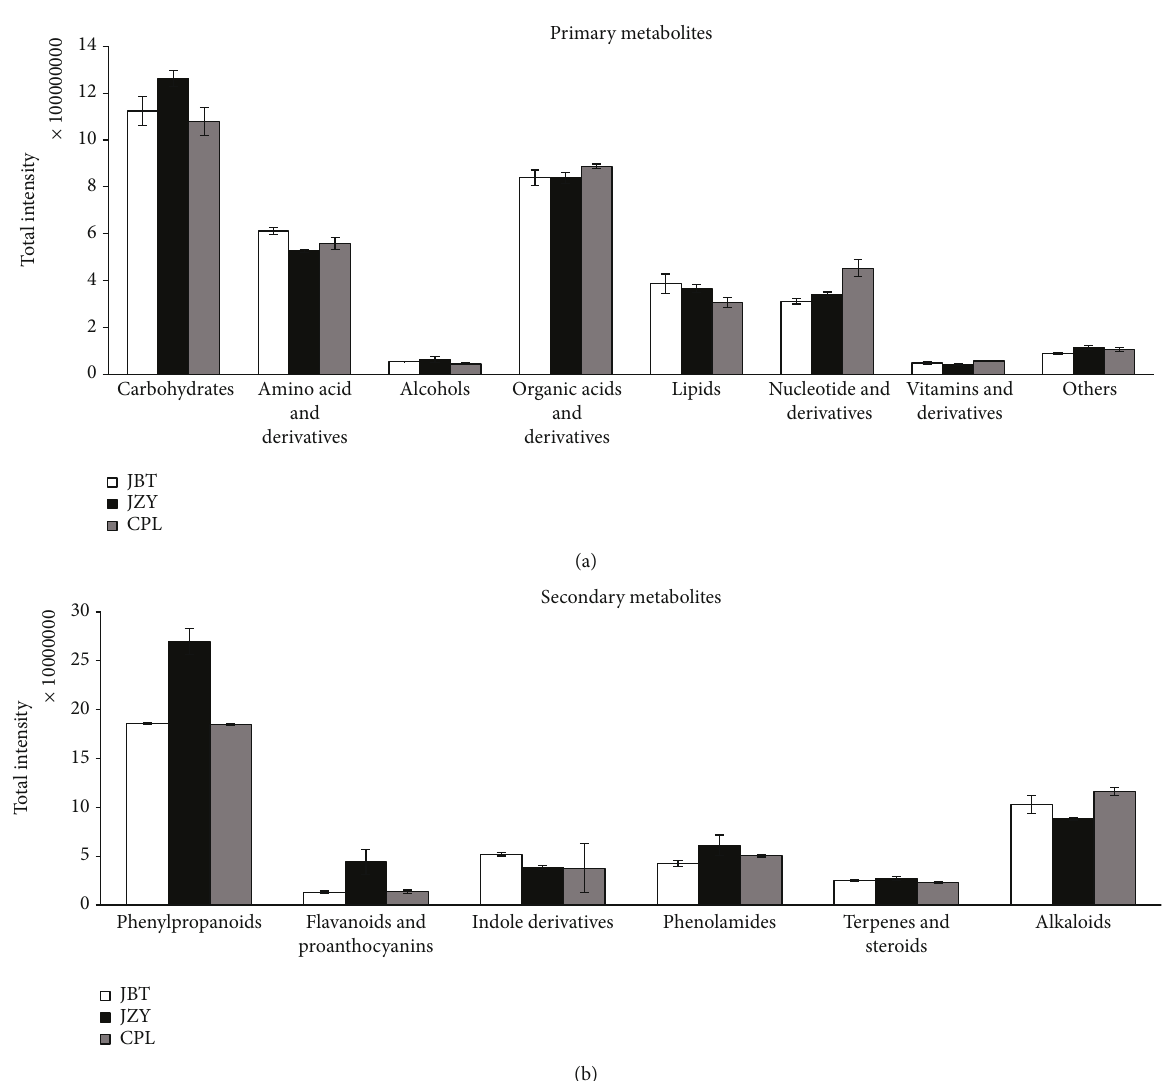
Figure 2: Detected metabolite distribution in sweet corn cultivars: (a) primary metabolites; (b) secondary